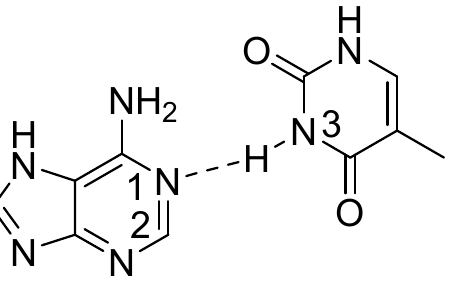
Figure 22. Example of hydrogen bonding in an adenine:thymine base pair.